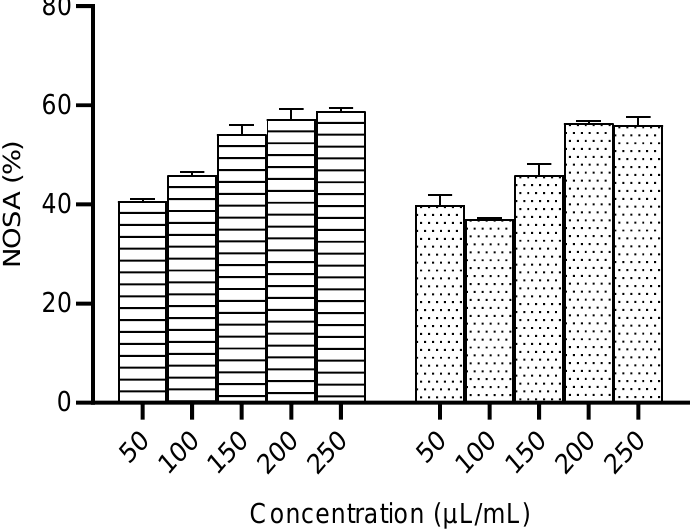
Figure 6. Percentage of nitric oxide scavenging activity [IC 50 values: carvacrol = 127.61 µL/mL; SEO = 165.18 µL/mL]; SEO—seed essential oil; NOSA—nitric oxide scavenging activity.